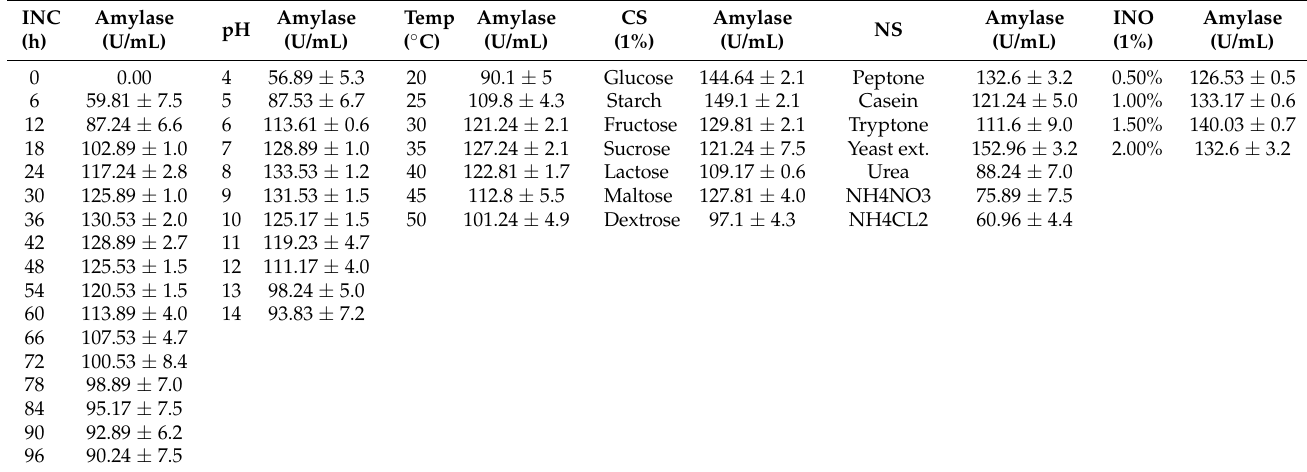
Table 1. Influence of various physico-chemical variables on amylase production by Bacillus sp.